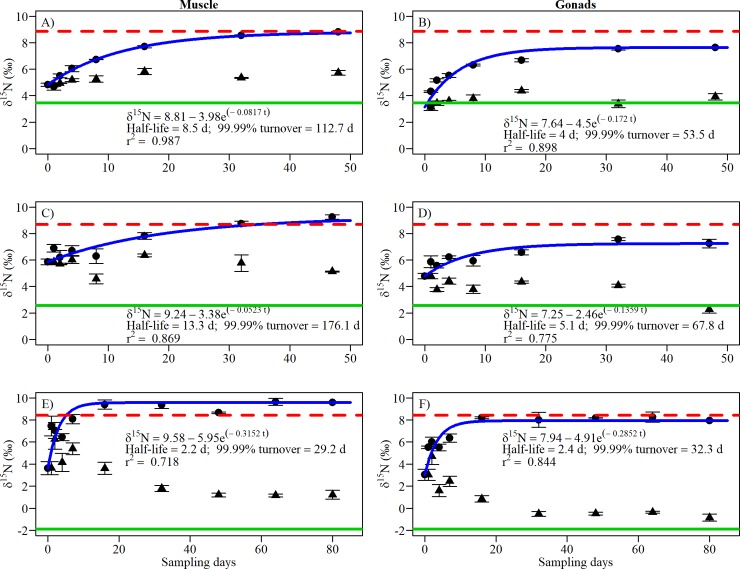
δ15N values of muscle (left) and gonad tissue (right) per sampling day (mean ± SE) for three species of freshwater snails fed low-protein (triangles) or high-protein diet (dots).(A–B) Helisoma trivolvis, (C–D) Lymnaea elodes and (E–F) Lymnaea stagnalis. For each graph, the blue curve is the best fit, the dotted red line represents the mean δ15N value of the high-protein diet (n = 2 for A–F), and the green line represents the mean δ15N value of the lettuce diet (n = 4 for A–B, 5 for C–D, 3 for E–F).